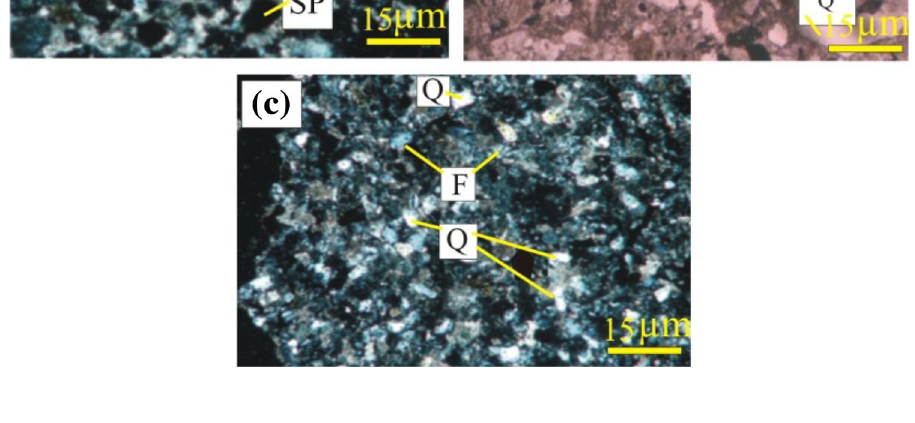
Fig. 5 Diagenetic sequence of the Kömürlü and Penek Forma- tions of the Aşkale